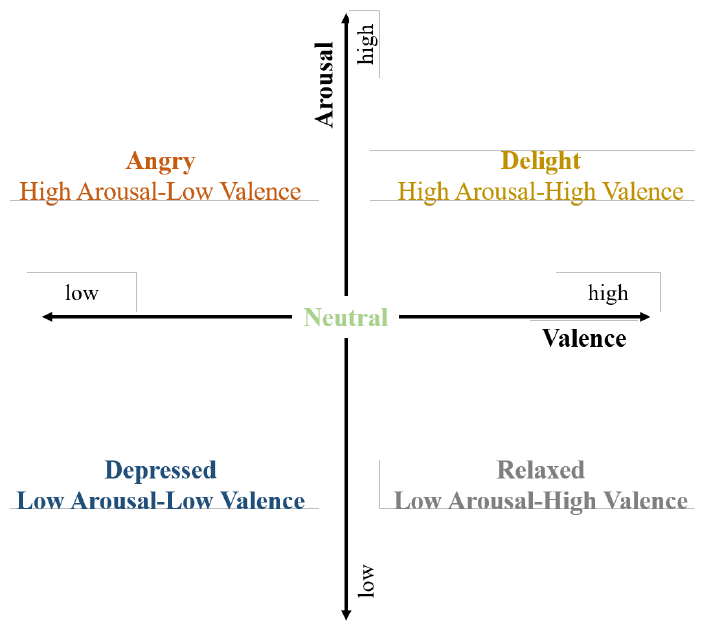
Figure 2. Arousal, valence two-dimension plane.